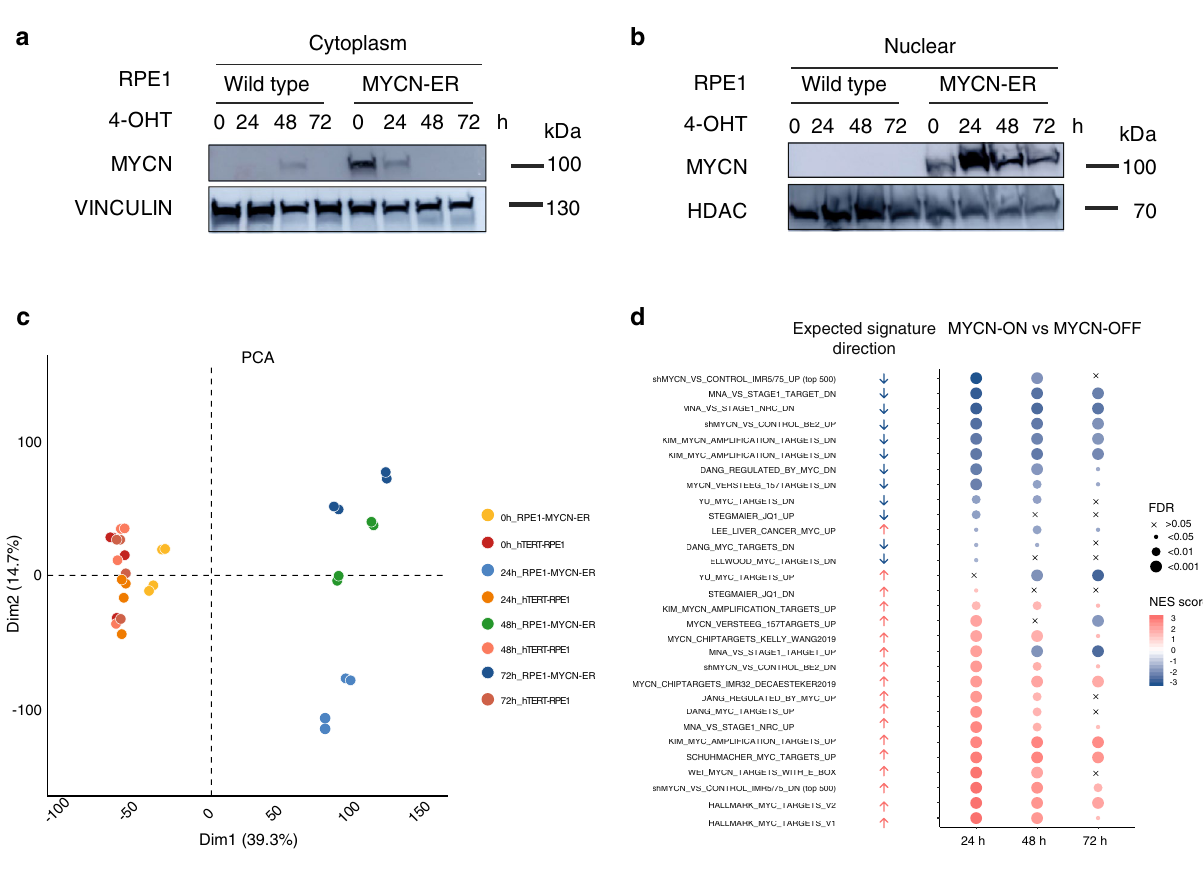
Figure 1. MYCN activation induces MYC/MYCN gene signatures with a specific and time-dependent transcriptional shift in MYCN-ON cells. Immunoblot of N-MYC nuclear ( a ) and cytoplasm ( b ) translocation in WT and RPE1-MYCN-ER cells upon 4-OHT treatment for 24, 48 and 72 h. Vinculin was used as a cytoplasmic marker and loading control ( a ) while HDAC1 was used as a nuclear marker and loading control ( b ). ( c ) Principal component analysis and clustering with all samples, before differential analysis. All genes with a cpm greater than 1 in at least 6 samples are used in the analysis. Counts are normalized using edgeR and the data are rlog transformed. ( d ) 30 public available bona fide MYC/MYCN targets gene sets enriched in MYCN-ON cells 24 h, 48 h and 72 h p.i. compared to MYCN-OFF cells. Arrows represent the theoretically expected regulation of each signature in a positive (red) or negative (blue) manner for RPE1-MYCN-ER cells after MYCN activation. FDR value is depicted by dot size, GSEA normalised enrichment score (NES) is depicted by the colour of the dot. Western blots were cropped for clarity; uncropped images can be found in Supplementary Fig.